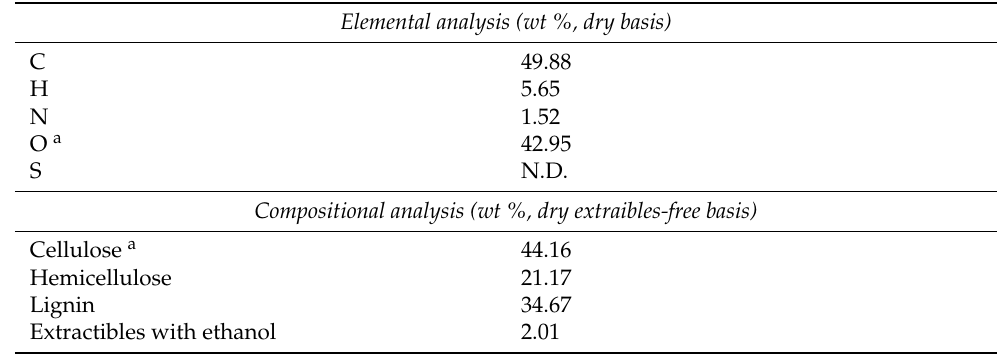
Table 1. Characterization of